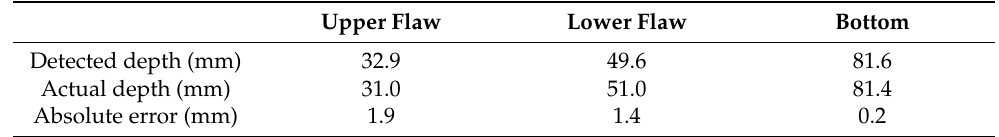
Table 3. Detection results of the proposed method for case